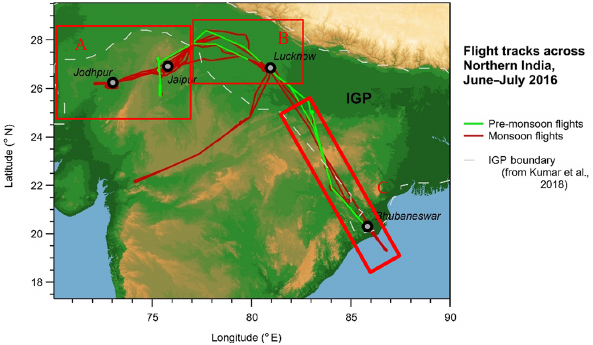
Figure 1. Flight tracks of the BAe-146 aircraft for the campaign across India during the pre-monsoon and monsoon seasons of 2016. The flight paths considered by this analysis are described in the main text and Table 1. Straight-level run (SLR) boundary layer sec- tions are split by region (A) west of IGP in NW India, (B) IGP, and (C) south-east of IGP in NE India. Map terrain created using Global multi-resolution terrain elevation data 010 (GMTED2010) (http://www.usgs.gov, last access: 21 October